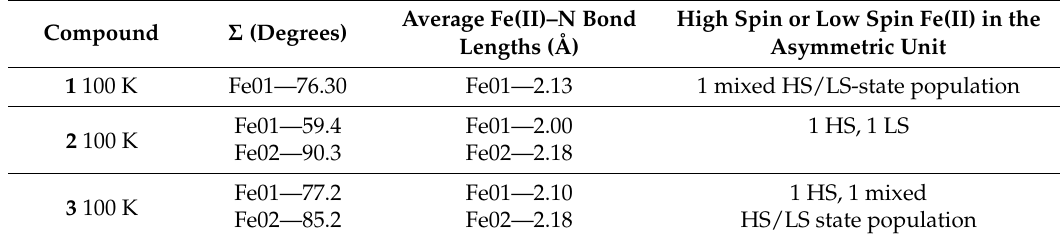
Table 1. Comparison of important spin cross-over related crystallographic values.